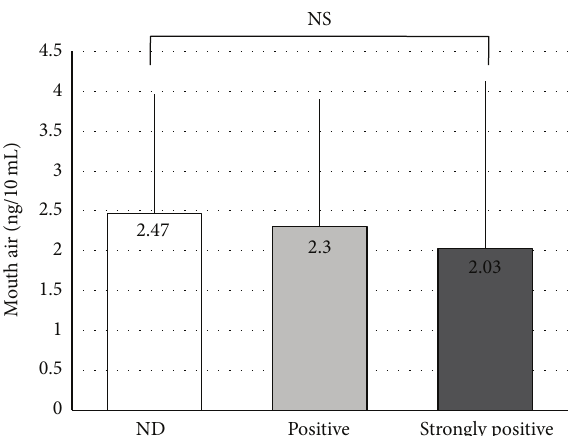
Figure 5: Correlations between the dimethyl sulfide measurements and Candida culture test results. NS: not significant. Vertical line: SD. Statistical comparison was performed using unpaired 𝑡